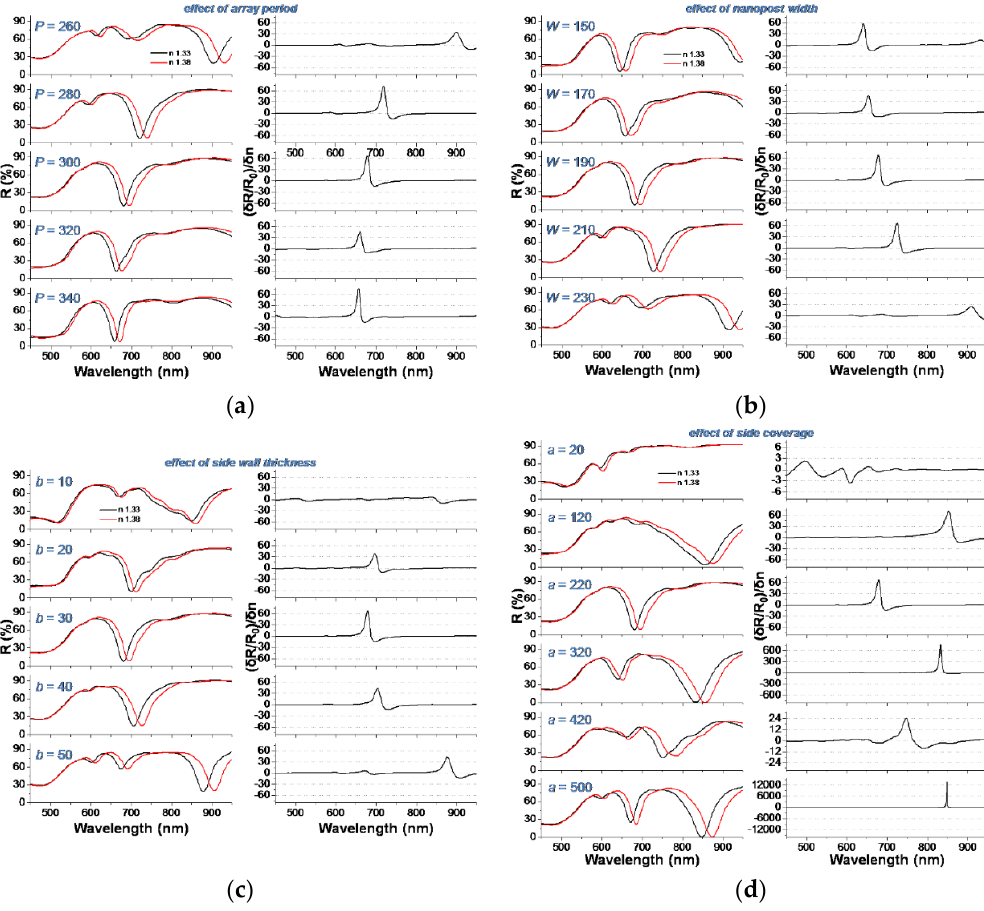
Figure 7. Dependence of the relative reflectivity variation per refractive index unit on several geometrical parameters of the nanopost-shell arrays: ( a ) array period P ; ( b ) nanopost width W ; ( c ) lateral coverage a of the nanopost by gold film; ( d ) lateral thickness b of the gold film on nanoposts.